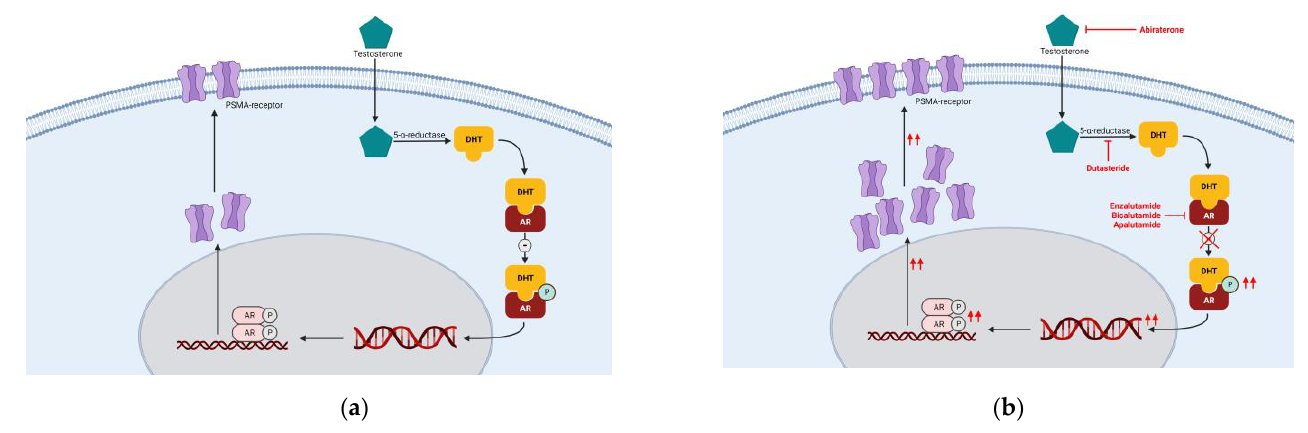
Figure 2. ( a ) Physiological pathway of androgens and regulation of PSMA receptors. DHT coupled to the androgen receptor has an inhibiting effect on the production of PSMA receptors; ( b ) Androgen blockage, for example, by enzalutamide, causes an upregulation of the PSMA receptor due to the loss of the inhibiting effect. DHT = dihydrotestosterone; AR = androgen receptor; PSMA = prostate-specific membrane antigen.